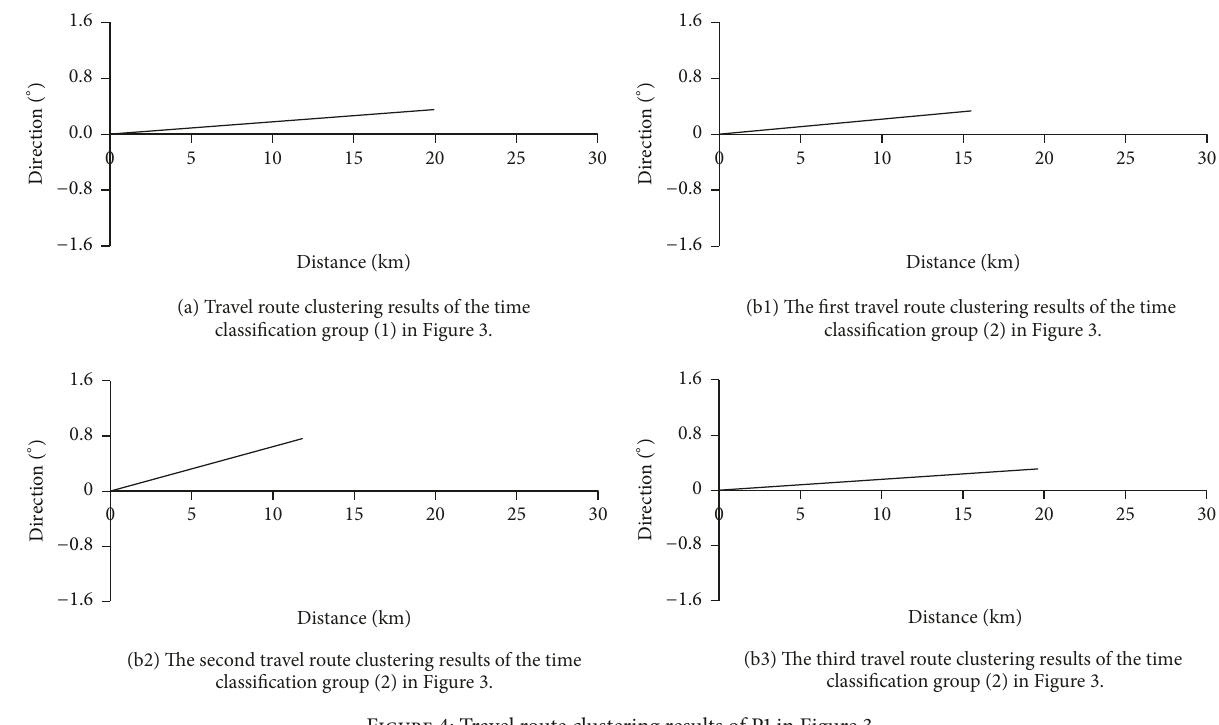
Figure 4: Travel route clustering results of P1 in Figure 3.